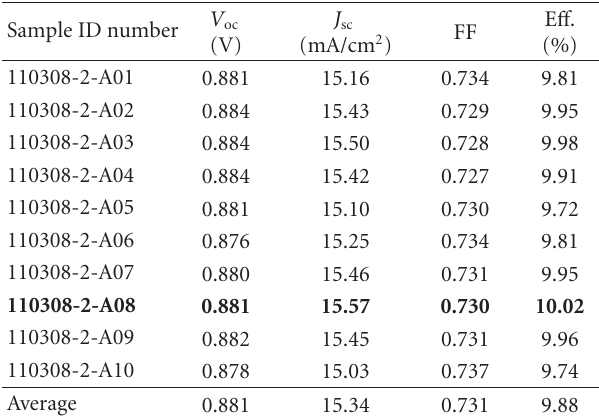
Table 5: p-i-n a-Si:H solar cells performance.